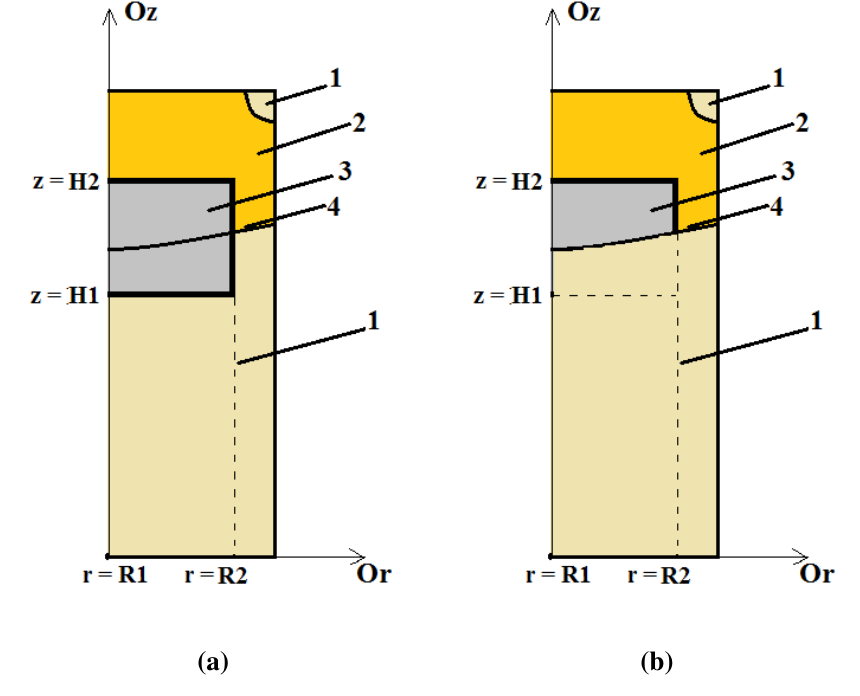
Figure 4. Geometrical characteristics on a half of the vertical ingot cross-section, R 1—solid metal; 2—liquid metal; 3—projection of D onto ( r, z ) plane; 4—liquid/solid metal contour. ( a ) D = [ R